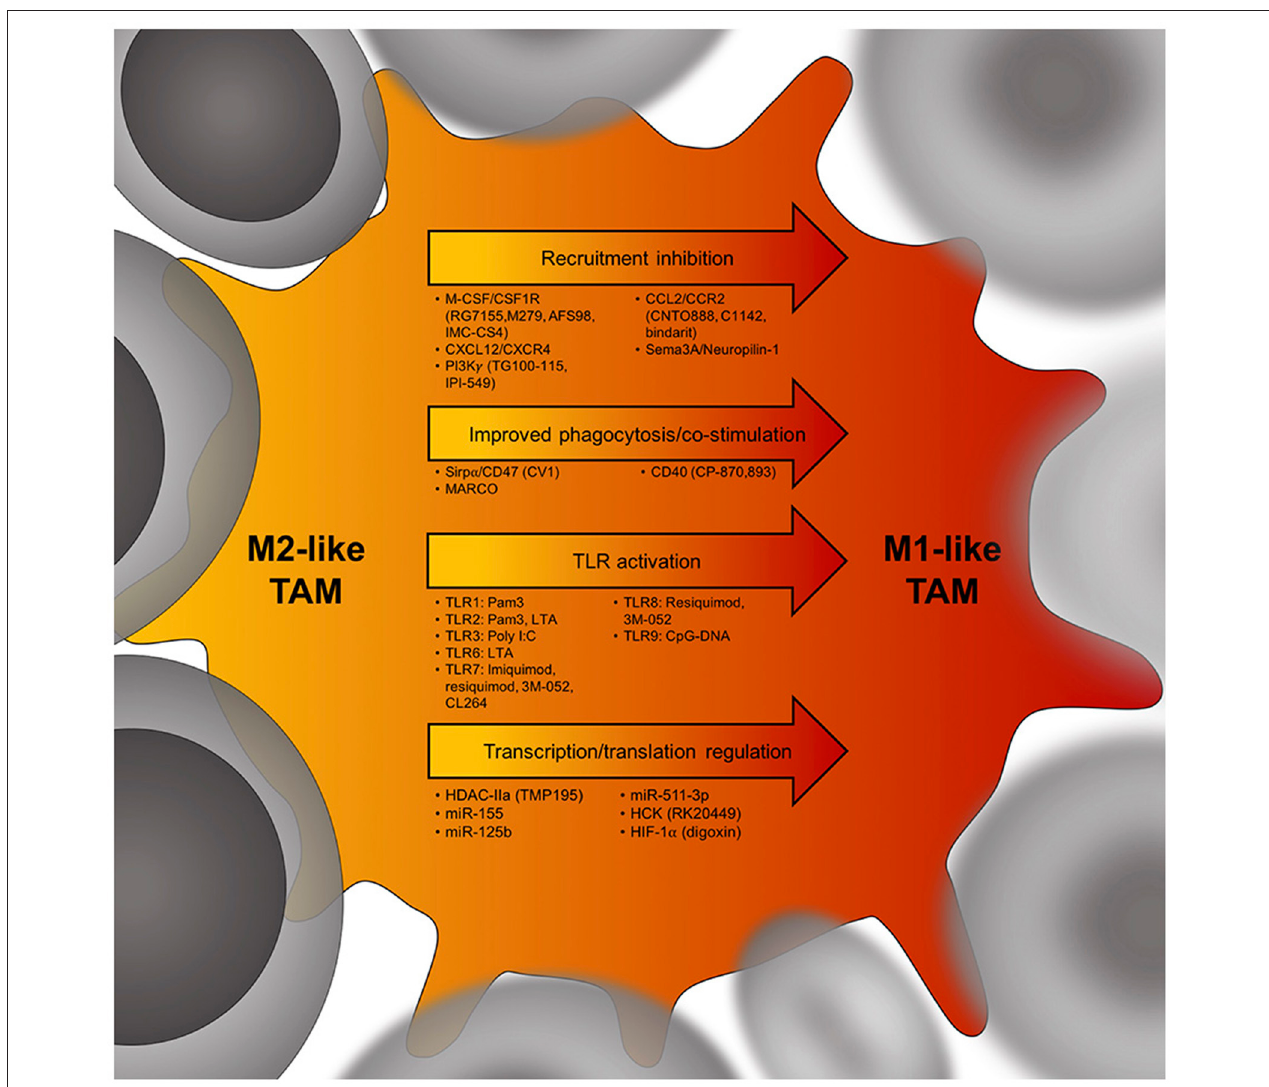
FIGURE 2 | Potential targets to skew the TAM phenotype from an immunosuppressive M2-like TAM (yellow) to an anti-tumor M1-like TAM (red). Cancer cells are in gray, arrows indicate potential targets to induce a TAM phenotype shift within tumors. Below each arrow are specific targets that could influence M2-like TAM phenotypes. M-CSF, macrophage colony-stimulating factor; CSF1R, colony stimulating factor 1 receptor; CXCL12, C-X-C chemokine ligand 12; CXCR4, C-X-C chemokine receptor 4; PI3K γ , phosphatidylinositol-3-kinase γ ; CCL2, C-C chemokine ligand 2; CCR2, C-C chemokine receptor 2; Sema3A, semaphorin 3A; Sirp α , signal regulatory protein alpha; MARCO, Macrophage receptor MARCO; CD40, cluster of differentiation 40; TLR, toll-like receptor; HDAC-IIa, histone deacetylase IIa; miR155, microRNA 155; HCK, proto-oncogene HCK; HIF-1 α , hypoxia-inducible factor